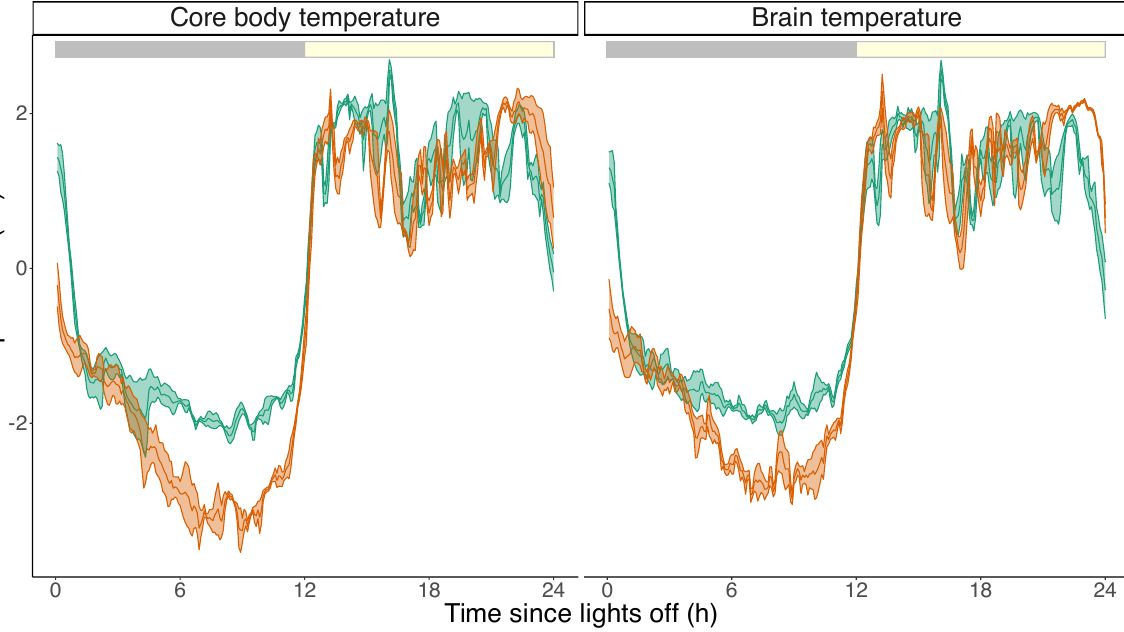
Figure 4. Average change in relative core body temperature ( left ) and brain temperature ( right ) in response to cold exposure sampled per 5 min ( n = 2). The red line denotes the baseline condition